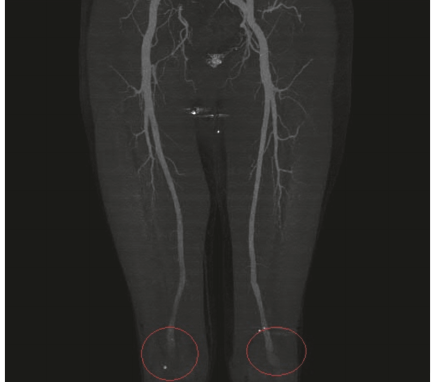
Figure 2: MRI of the heart with and without intravenous gadolin- ium contrast administration.